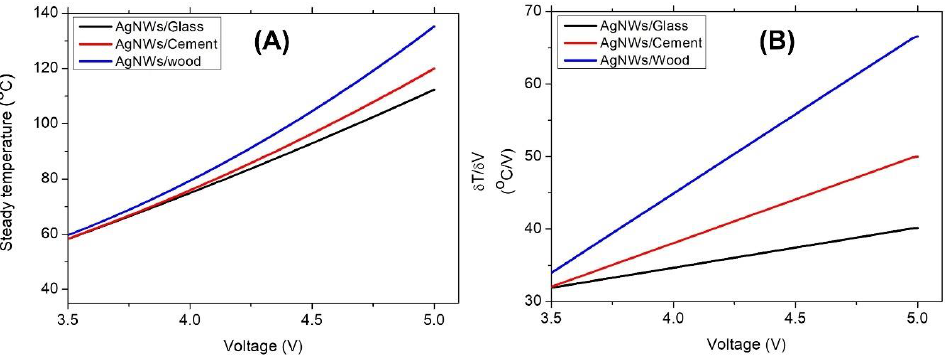
Figure 9. ( A ) The steady temperature via the bias voltage of the three heaters, and ( B ) the uncertainty of the steady temperature with respect to the uncertainty of the bias voltage.